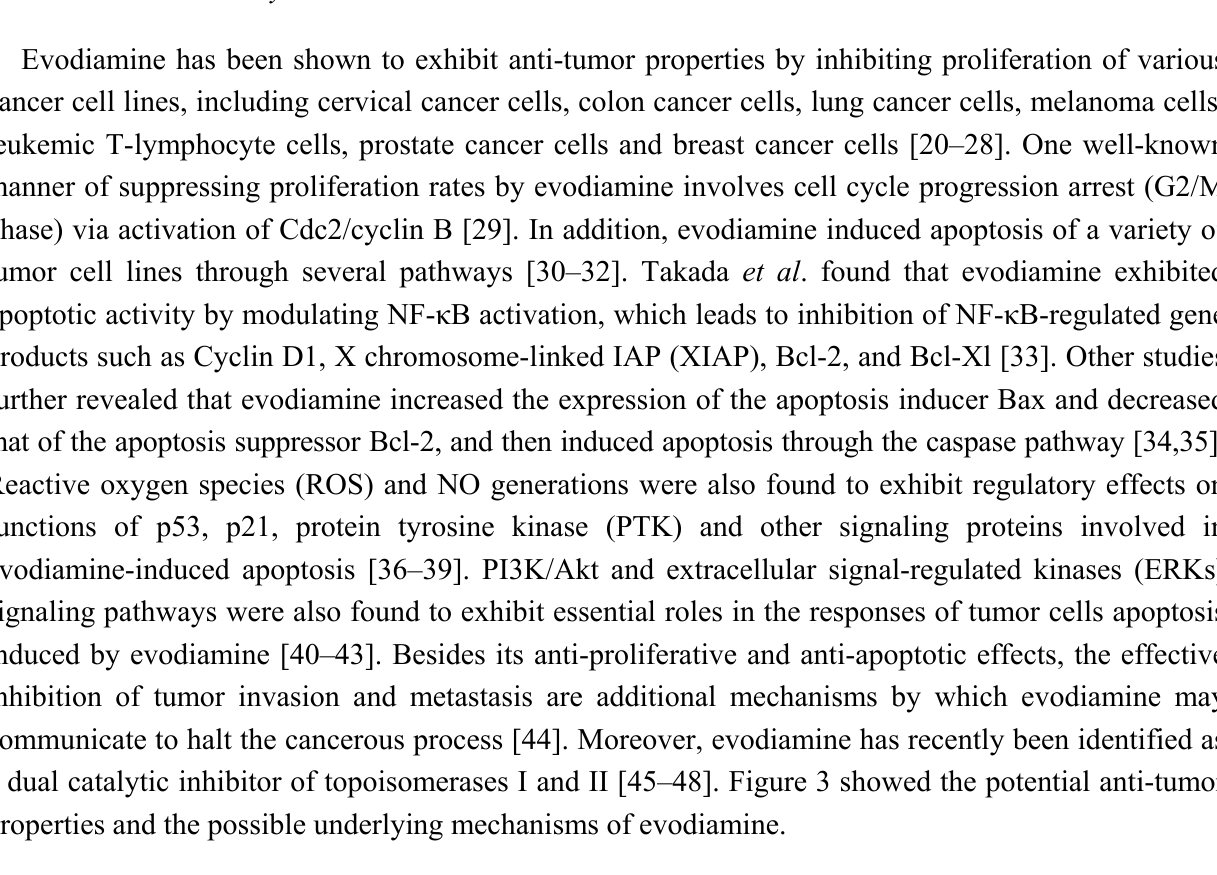
Figure 3. Demonstration of the potential anti-tumor properties and the possible underlying mechanisms of evodiamine. T-lines indicate inhibitory